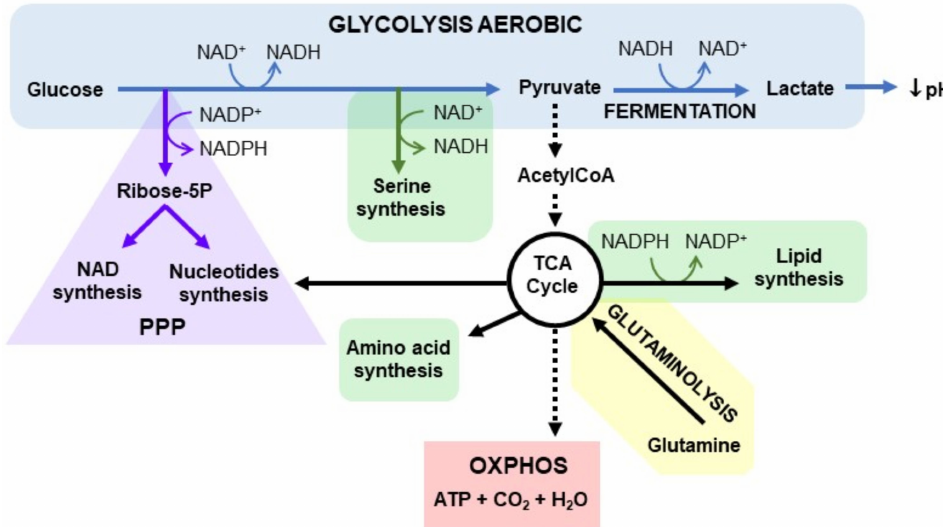
Figure 1. NAD+ metabolism. Tumour cells depend more on glycolysis (in blue) than on OXPHOS from the mitochondria (in dashed black). The pentose phosphate pathway (in purple), serine biosynthesis (in green), and fatty acid synthesis (in red) are highly activated in cancer and depend on glycolysis, which is the axis of cancer metabolism. Glutaminolysis (in brown) is also increased as the main source of nitrogen in the cell. The NAD+/NADH and NADP+/NADPH cofactors participate in all these pathways, allowing rapid energy production, the elimination of excess ROS, and the synthesis of macromolecules to support tumour proliferation and